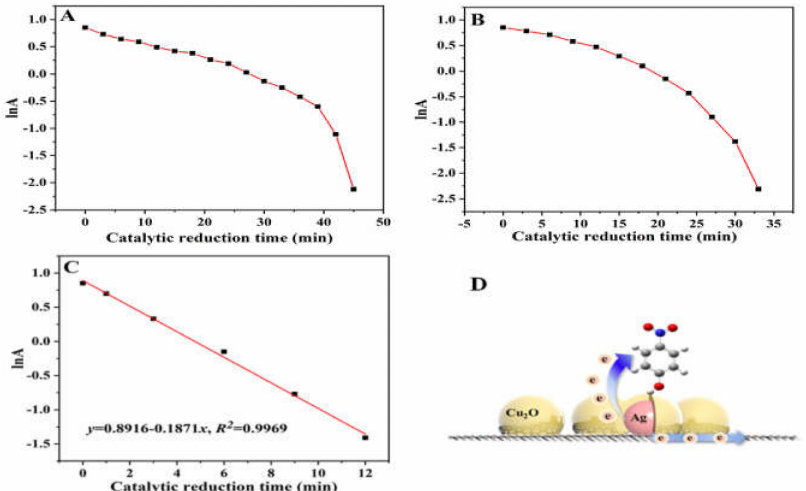
Figure 5. The logarithm of the absorbance at 400 nm vs. catalytic reduction time by using ( A ) Cu 2 O, ( B ) Ag@Cu 2 O, and ( C ) Ag@Cu 2 O-rGO materials. ( D ) The schematic of the catalytic mechanism of 4-NP on the Ag@Cu 2 O-rGO interface. The 4-NP is adsorbed on Ag@Cu 2 O-rGO, BH 4 − ion provides electrons for catalysis, and the electrons migrate between Ag@Cu 2 O and rGO in a depletion region near the Ag@Cu 2 O-rGO interface, forming an electron-rich region. These excess electrons in the presence of rGO promote the absorption of electrons by 4-NP molecules near these regions. Thus, the catalytic efficiency is considerably